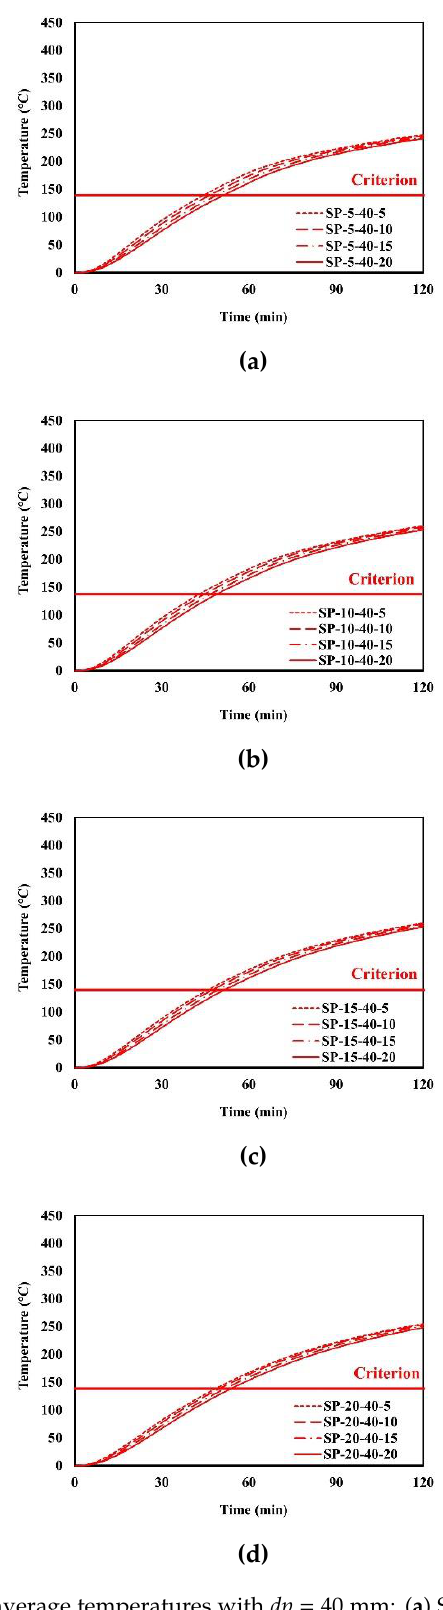
Figure 15. Time history of maximum Figure 16. Time history of average Figure 16. Time history of average temperatures with dp = 40 mm: ( a ) SP-5-40-x; ( b ) SP-10-40-x; ( c ) temperatures with dp = 40 mm: ( a ) SP-5-40- temperatures with dp = 40 mm: ( a ) SP-5-40- SP-15-40-x; ( d ) x; ( b ) SP-40-20-x; ( c ) SP-15-40-x; ( d ) SP-20- x; ( b ) SP-10-40-x; ( c ) SP-15-40-x; ( d ) SP-20- 40-x. 40-x.